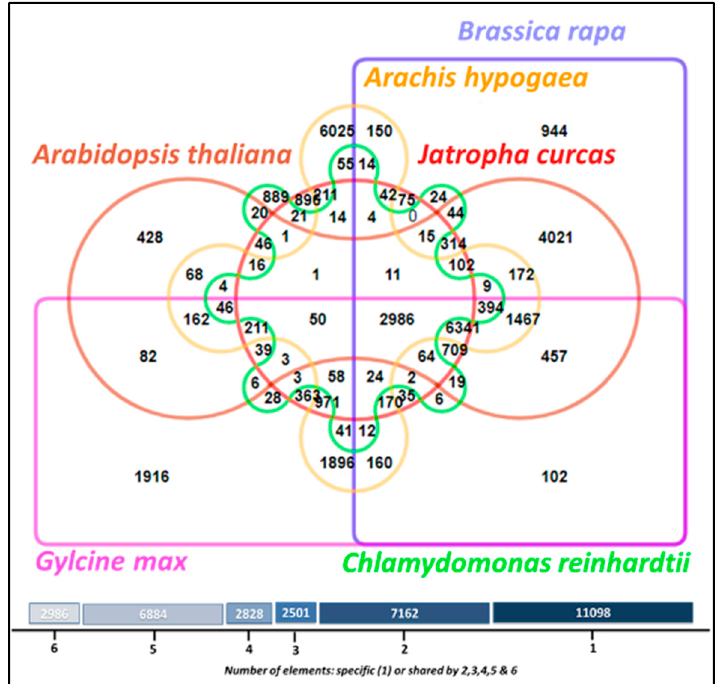
Figure 6. Venn diagram representing the orthologous protein clusters shared among J. curcas , Glycine max , Arabidopsis thaliana , Arachis hypogaea , Brassica rapa , and Chlamydomonas reinhardtii .